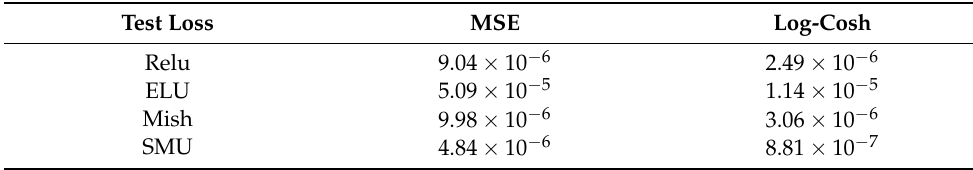
Table 2. Comparison of the convergence of different activation functions and loss functions when training DNN equivalent flat capacitance models containing DMFs.